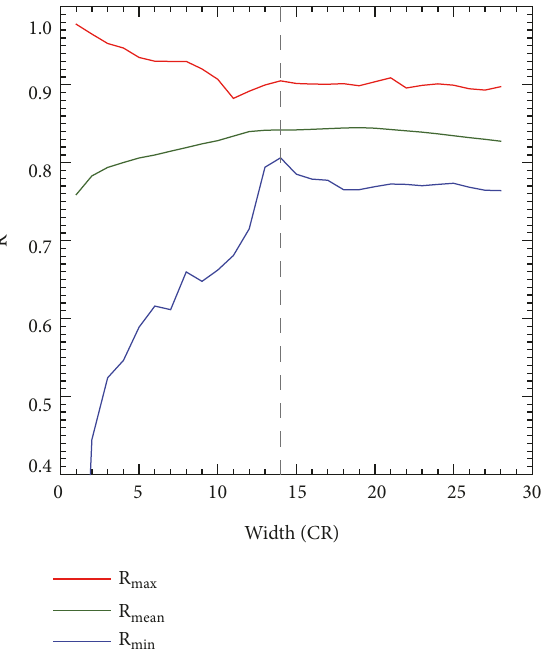
Figure 6: The correlation coefficientbetween fitted Y and F 10.7 with different widths in moving fit from 2012 to 2013. R min (blue line), R max (red line), and R mean (green line) correspond to the minimum, maximum, and average of the correlation coefficient,